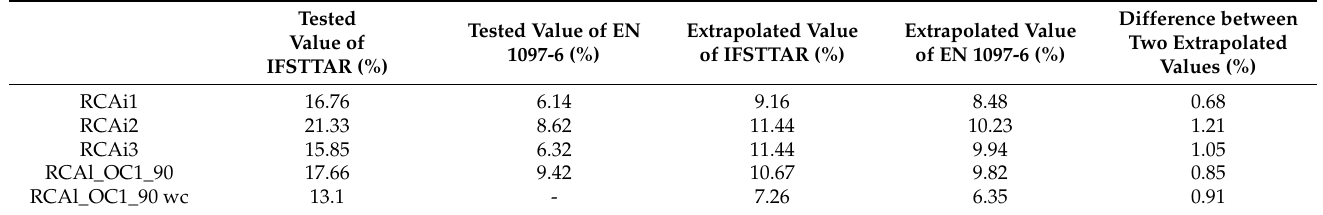
Table 10. Extrapolated water absorption of Fraction 0/0.63mm from standard EN and IFSTTAR for industrial RCA and laboratory-manufactured